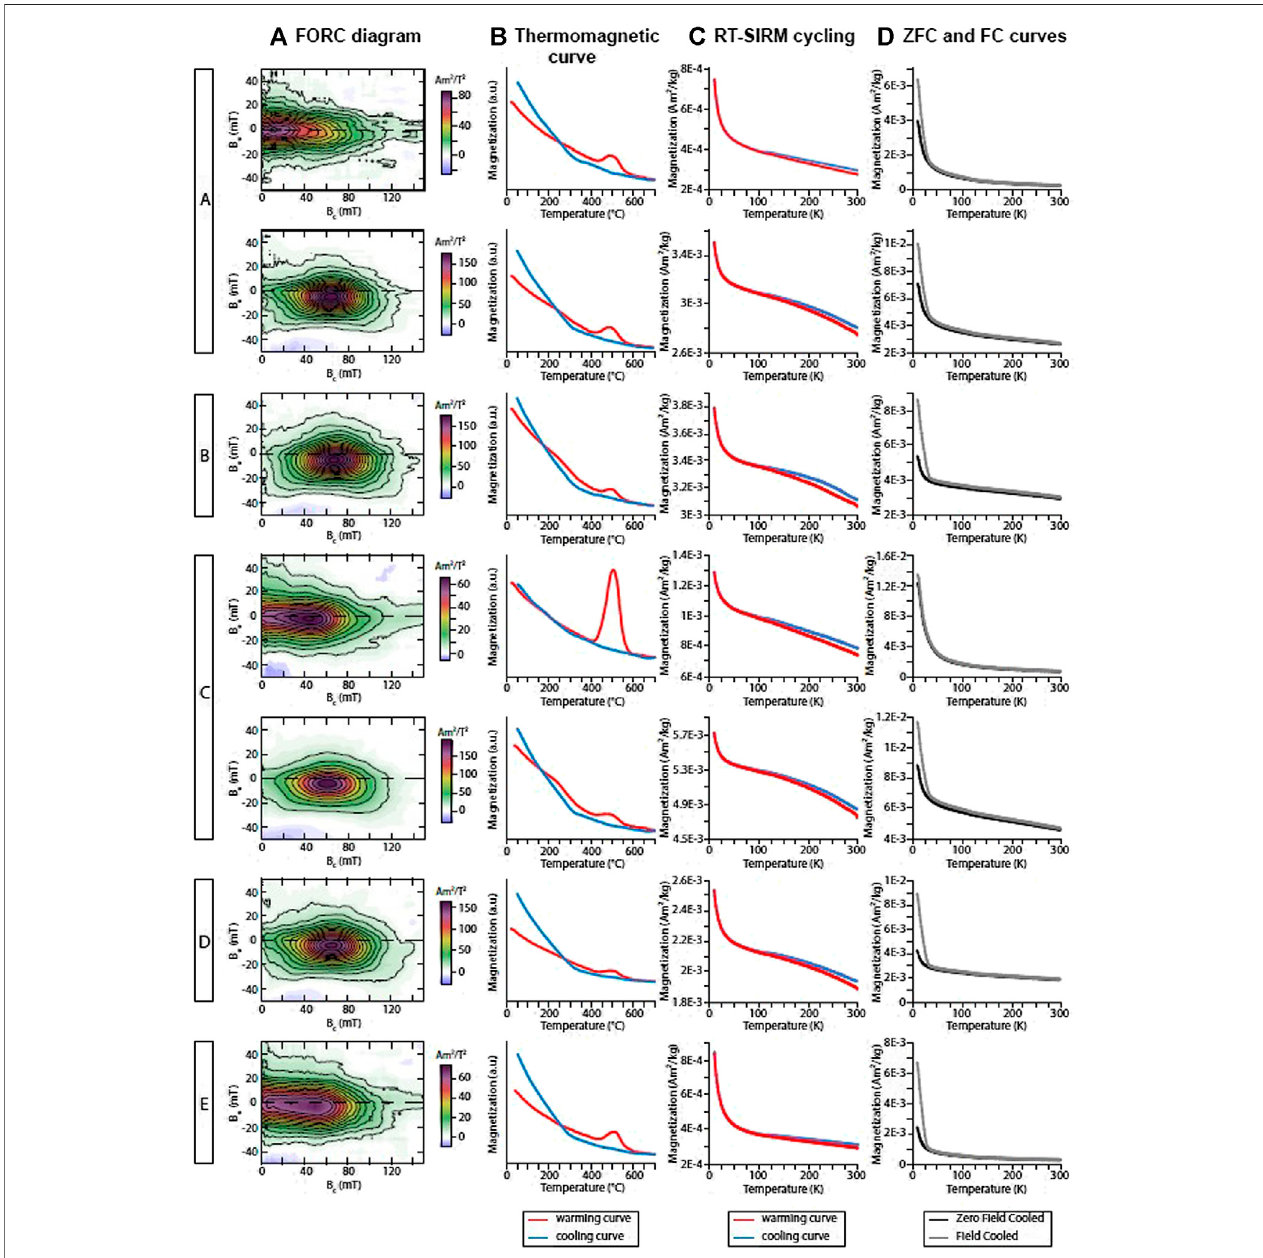
FIGURE 4 | Representative rock magnetic measurements for samples of the different coercivity zones (shown on the left) (A) FORC diagram (B) Thermomagnetic curve (C) RT-SIRMcyclingand (D) ZeroFieldCooled(ZFC)andFieldCooled(FC)curves.Selectedsamplesarefromtoptobottom:U1518E-7H-5W,13 – 15 cm(depth (cid:1) 52.54 mbsf), U1518E-12F-2W, 22 – 24 cm (depth (cid:1) 68.75 mbsf), U1518F-2R-1W, 44 – 46 cm (depth (cid:1) 198.14 mbsf), U1518F-13R-2W, 99 – 101 cm (depth (cid:1) 305.52 mbsf), U1518F-15R-2W, 67 – 69 cm (depth (cid:1) 324.29 mbsf), U1518F-29R-3W, 6 – 8 cm (depth (cid:1) 459.48 mbsf) and U1518F-32R-6W, 2 – 4 cm (depth (cid:1) 490.57 mbsf). Samples from Coercivity Zone C are discussed in Greve et al.